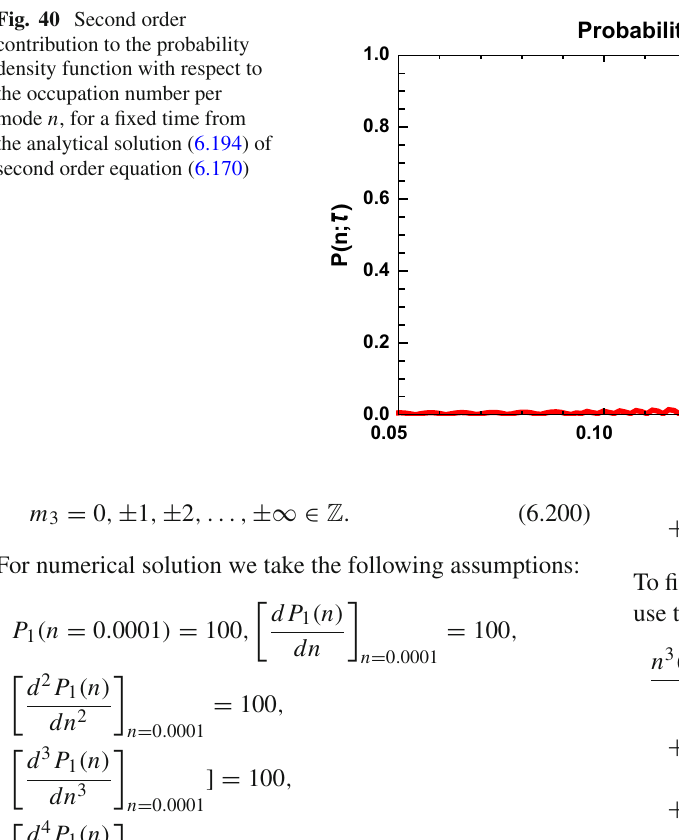
ProbabilityDistribution for 2 nd order